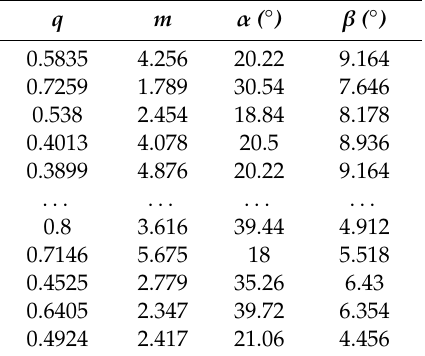
Table 1. Design parameters and efficiency of DOE sample points.